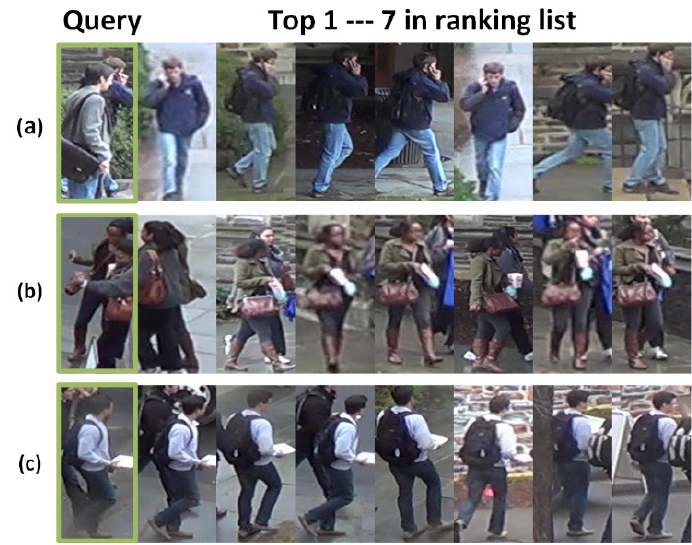
Figure 7. The visualization of sorting results for AML baseline. ( a ) Sample 1; ( b ) Sample 2; ( c ) Sample 3.